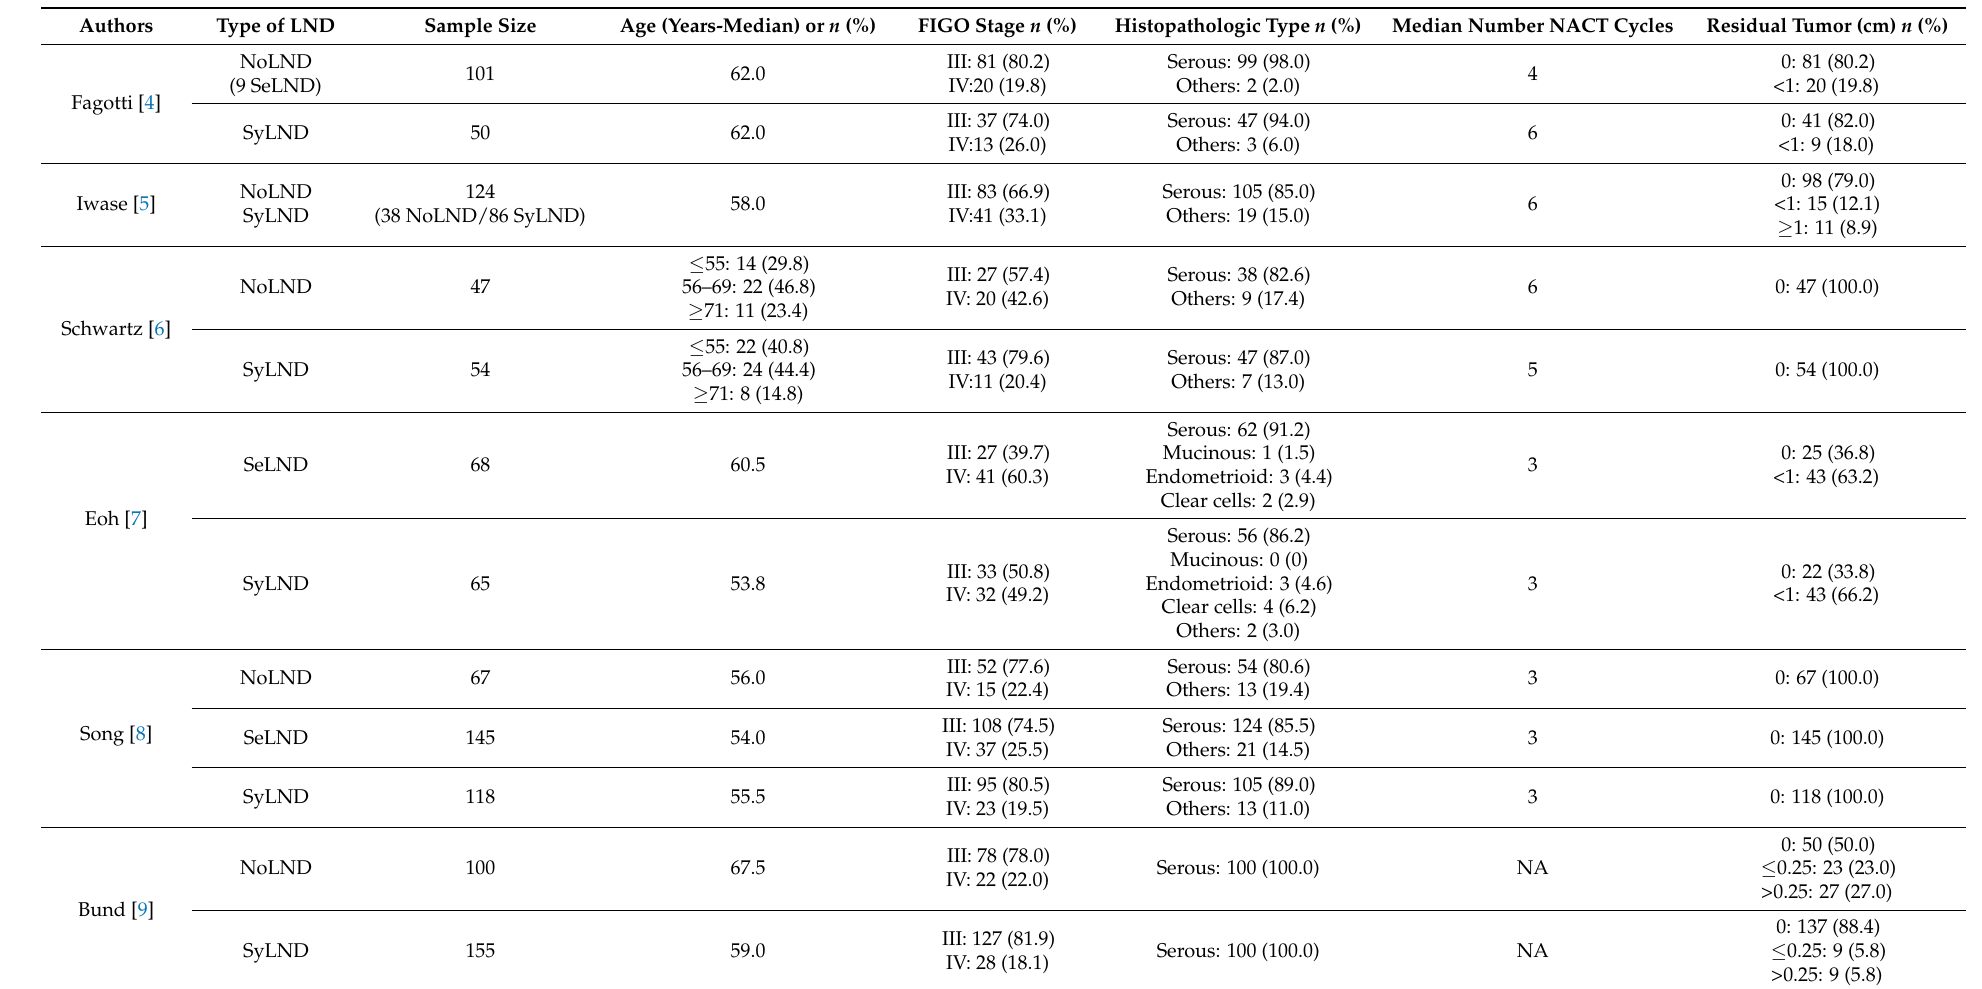
Table 1. Studies’